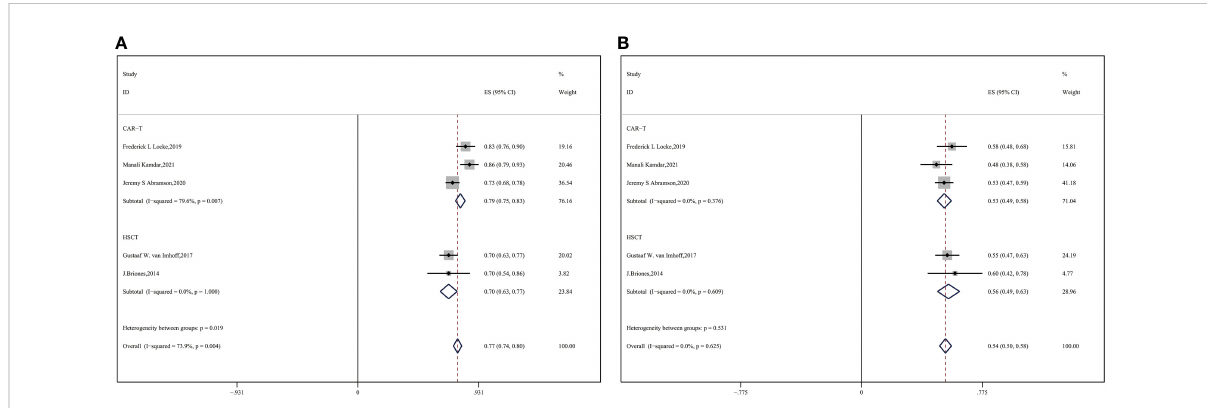
FIGURE 5 Subgroup analysis by ECOG scores between CAR-T and auto-HSCT groups (A) ORR (B)